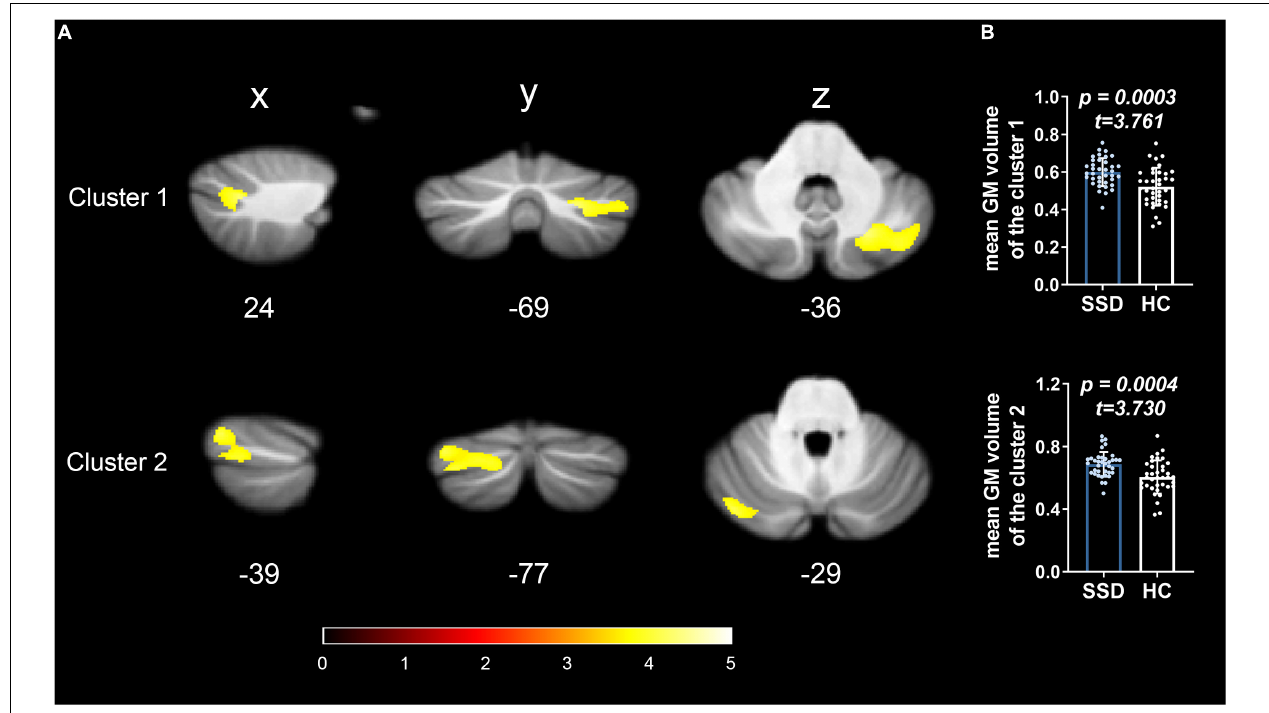
FIGURE 1 | GMV alterations in the cerebellum of patients with SSD detected by spatially unbiased infratentorial–VBM. Compared with HC, patients with SSD showed significantly increased GMV in the two regional clusters in the posterior cerebellar lobes. (A) Cluster 1 was located in right lobules crura I and II; cluster 2 was located in the left lobules crus II and crus I. (B) The bar graphs show the comparison of the average GMV values, and the error bars represent SD.